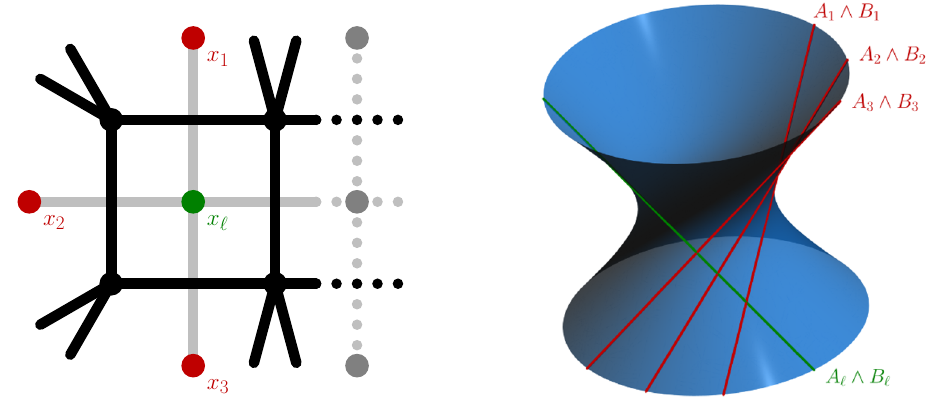
Figure 2 . Relationship between the endcap of the traintrack and the